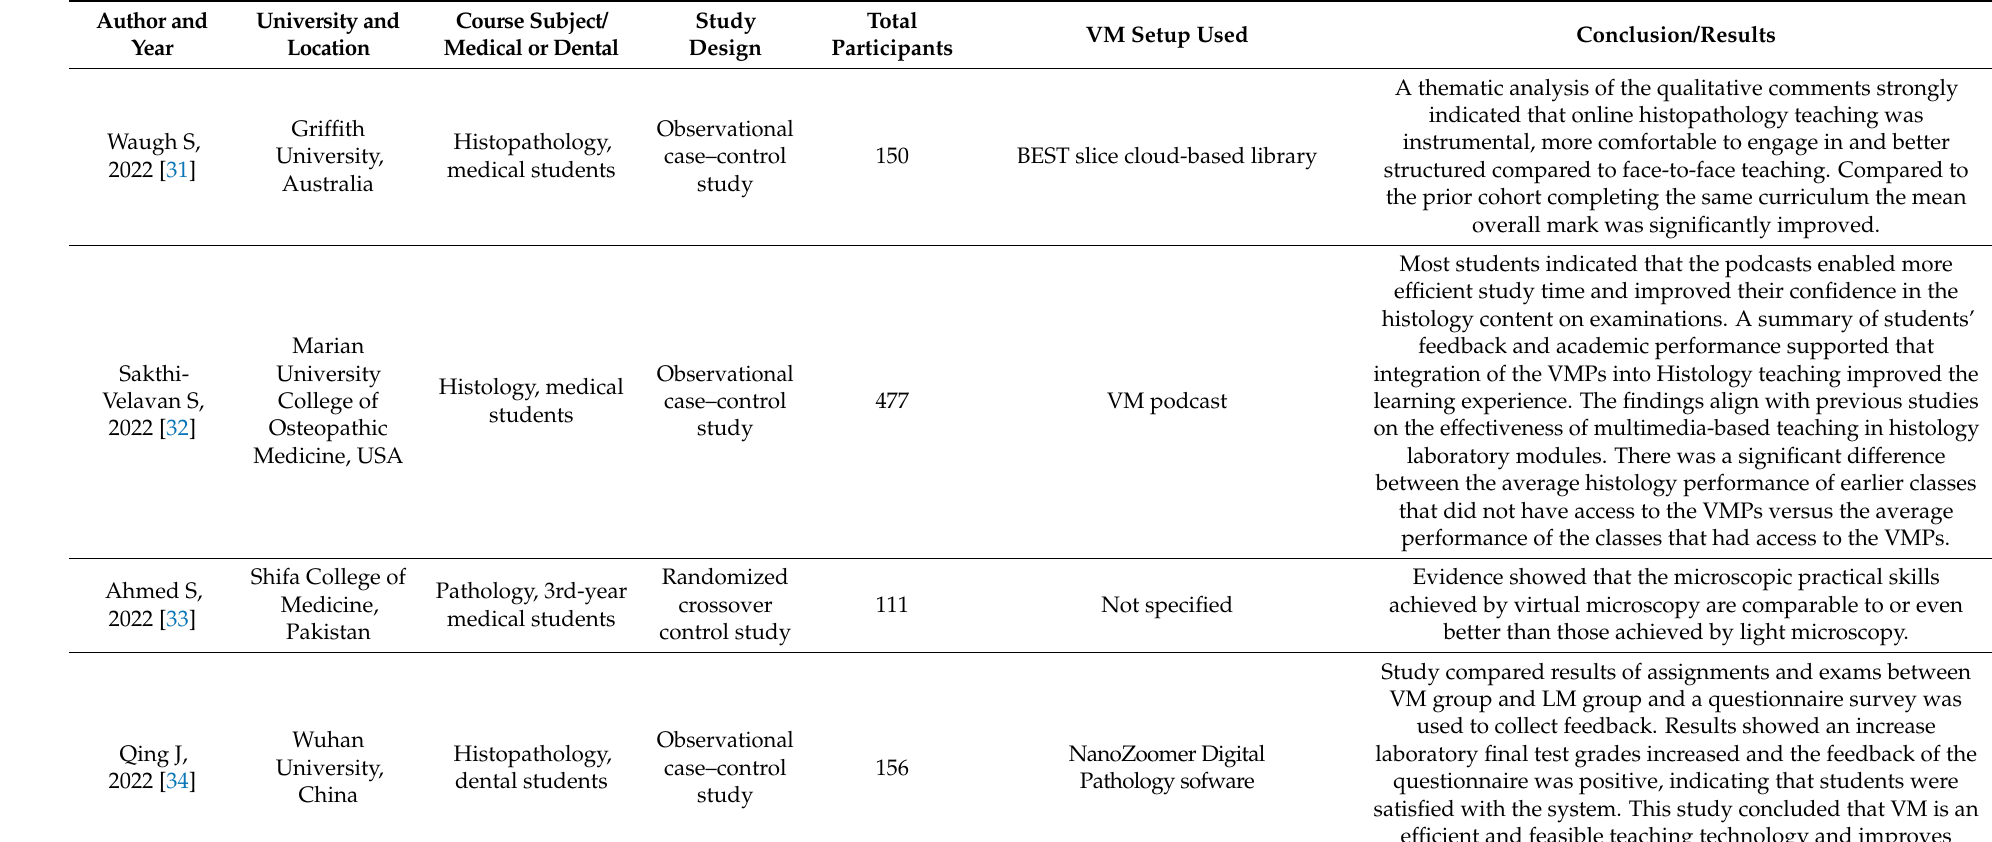
Table 1. Characteristics of all included